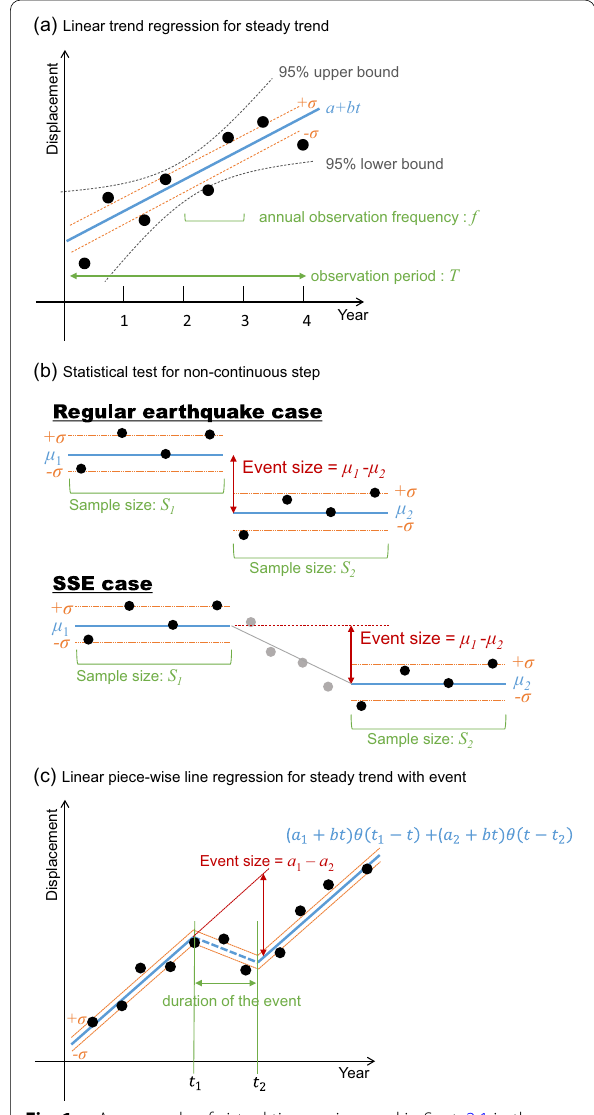
Fig. 1 a An example of virtual time series used in Sect. 2.1 in the case of observation frequency ( f ) 2 times/year. Blue, orange and = gray lines indicate a fitting line, 1 σ ranges and the 95% confidence ± levels (CL) for the linear fitting, respectively. Green arrow indicates an observation period ( T ). b An example of virtual time series used in Sect. 2.2 in a regular earthquake case (upper) and an SSE case (bottom). Sample sizes S 1 and S 2 are the numbers of the data before and after the event, respectively. An event size is depicted by a red arrow. c An example of virtual time series used in Sect. 2.3. In this virtual data, the standard deviation σ is given to the functions represented by Eqs. (3) and